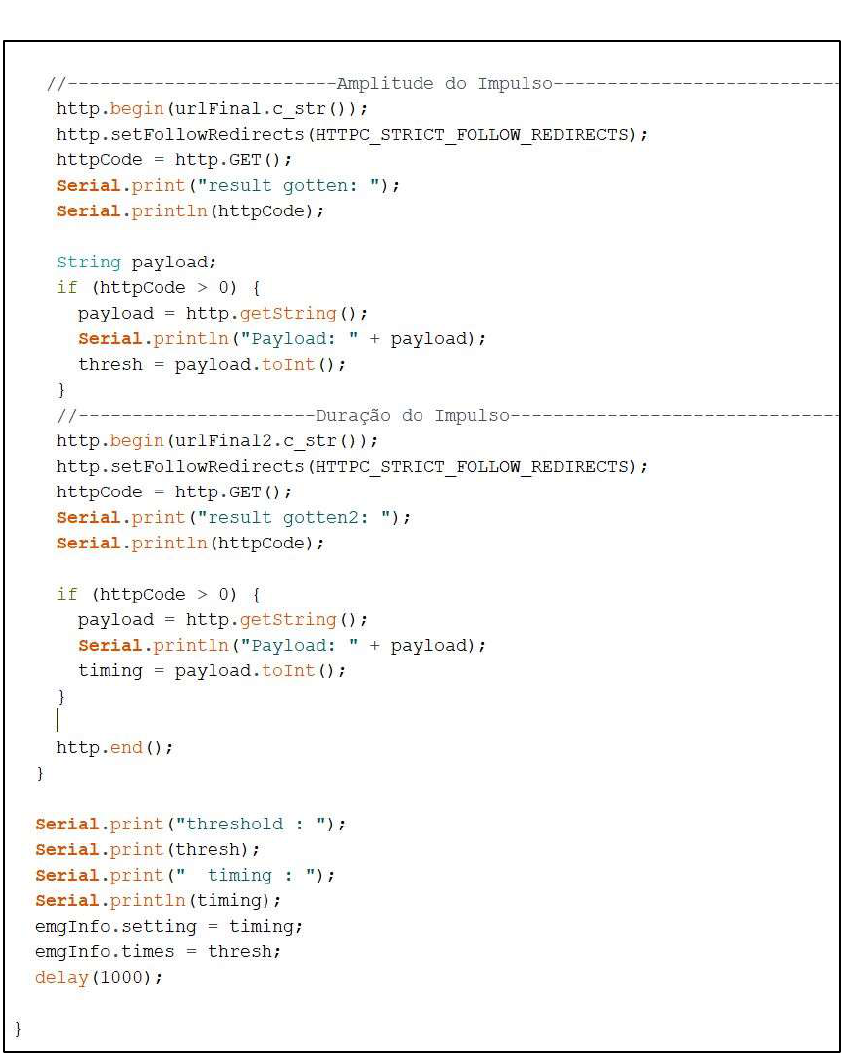
Figure 6. Code 5 — retrieving the values contained in the Google Sheet. Figure 6. Code 5—retrieving the values contained in the Google